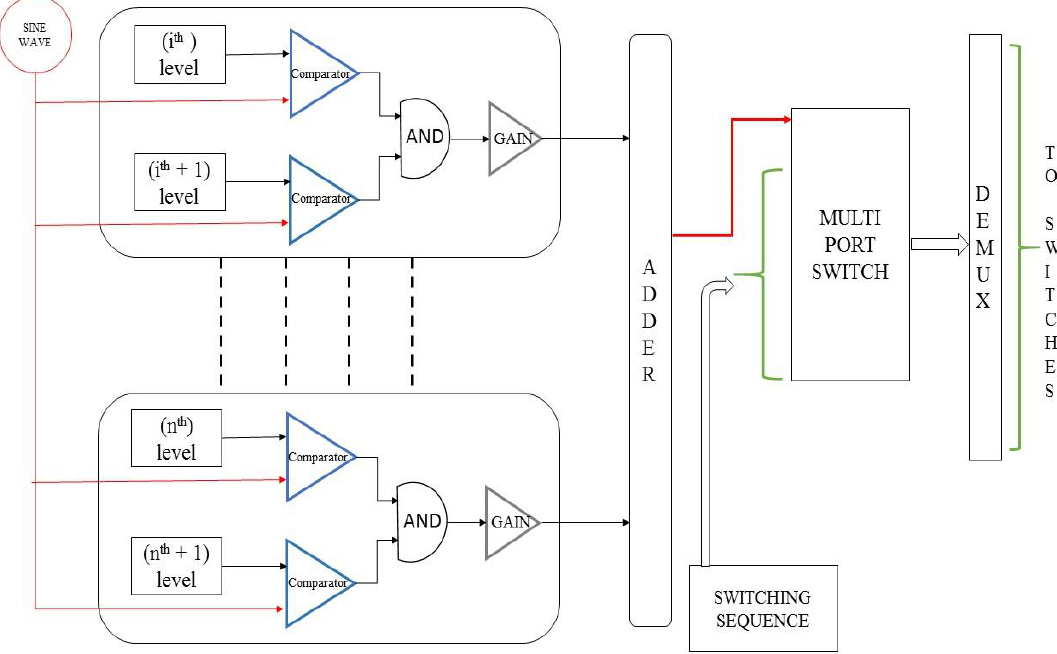
Figure 10. Block representation of pulse generation for the switches in the Tri-state inverter.